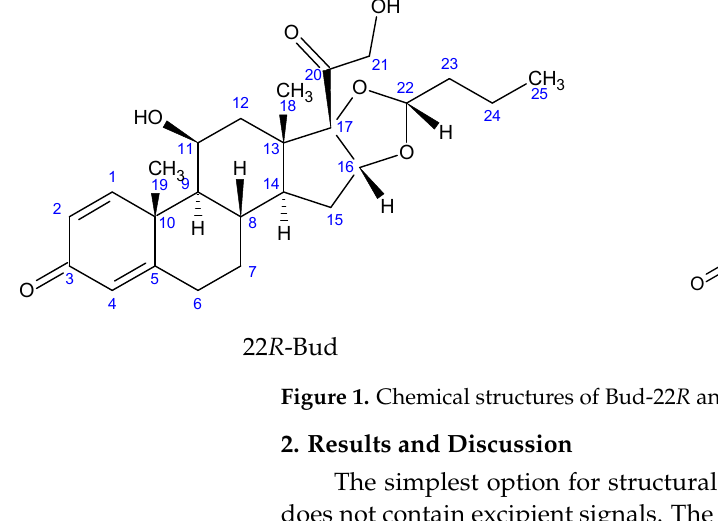
Table 1. Spectral characteristics of 22 R -Bud and 22 S